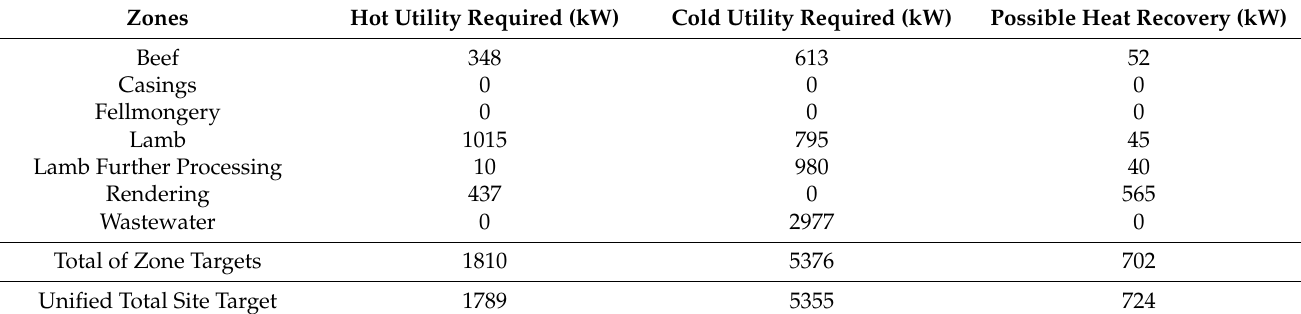
Table 3. Summary of results from TSHI of case study site zones adjusted for MVR and centralized heat pump incorporation.